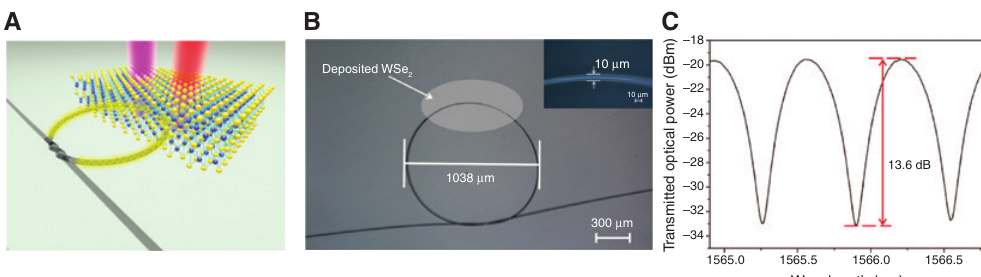
Figure 1: The schematic diagram and transmission spectrum of the device. (A) Diagrammatic drawing of the WSe -coated MKR structure. (B) Microscopic of the MKR structure with a loop diameter of D = ~ 1038 μ m, and 2 the inset shows enlarged image of the ring area with a diameter of d = ~ 10 μ m. (C) Transmission spectrum of the MKR with the largest ER of 13.6 dB at the resonance around 1565.9